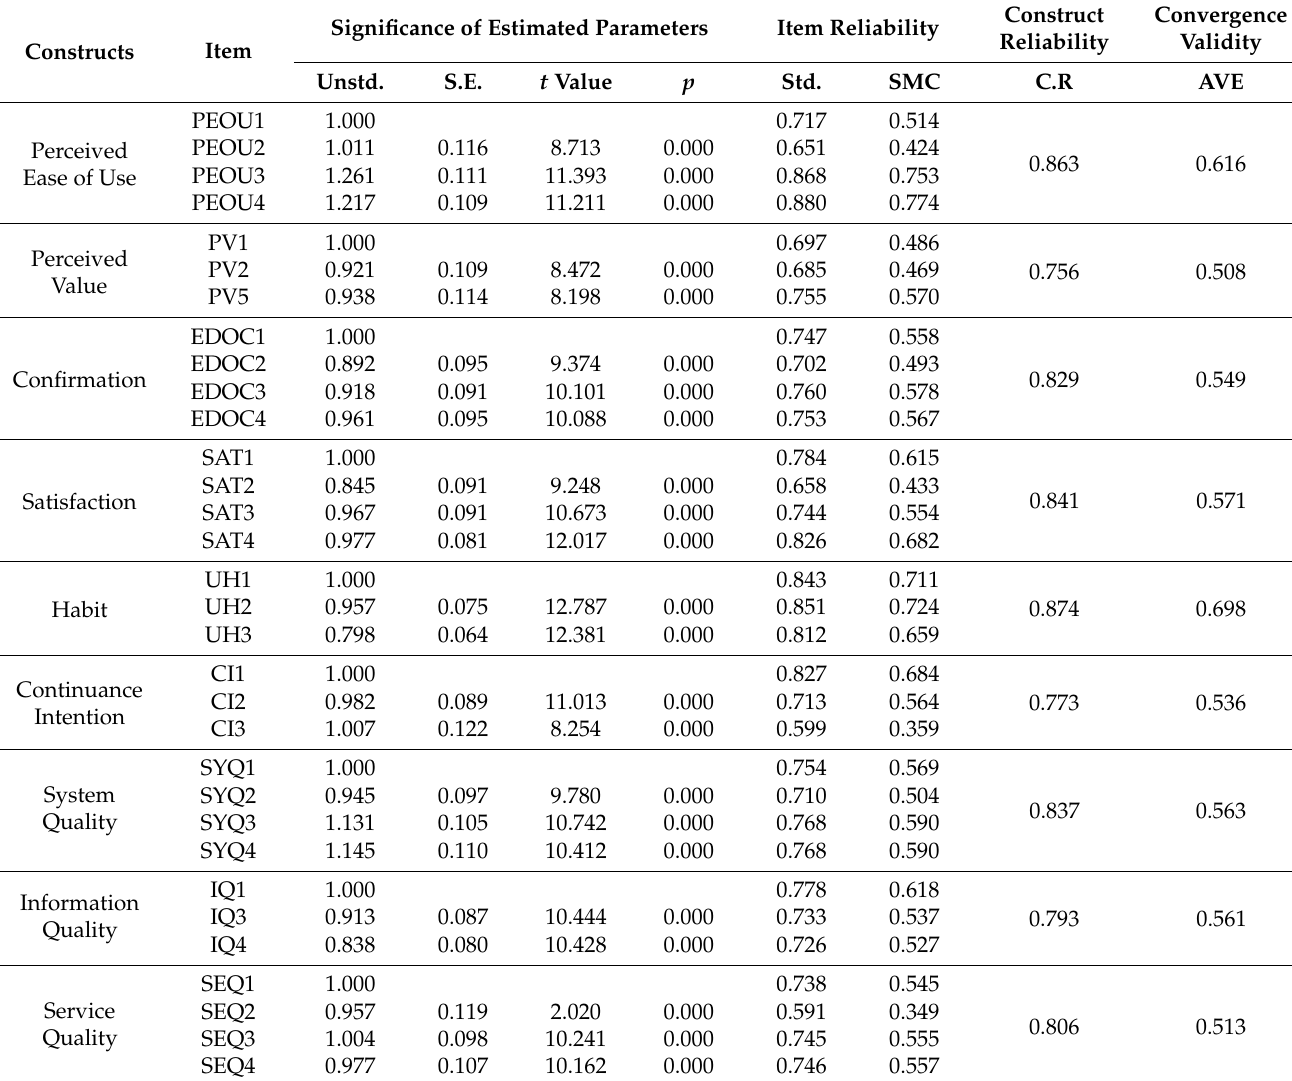
Table 2. Results for the measurement